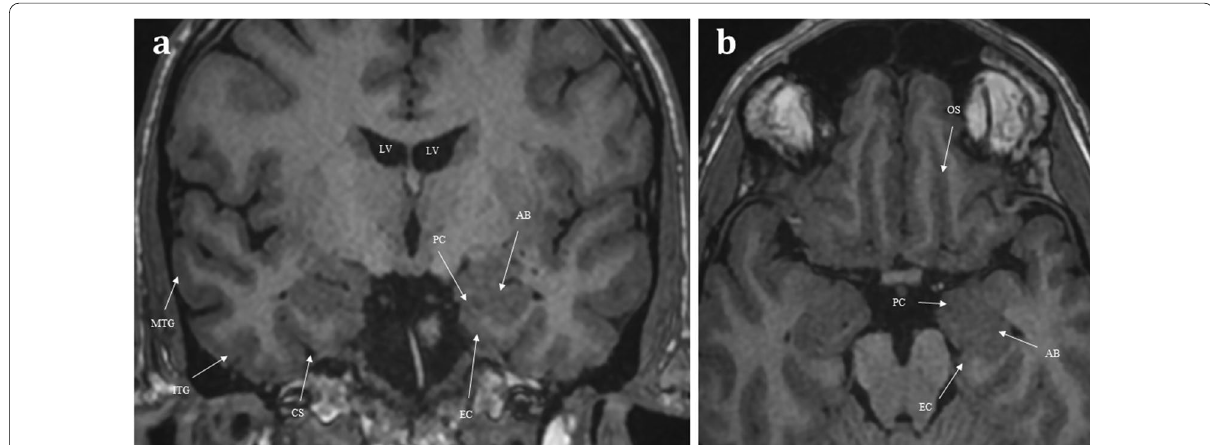
Fig. 3 Coronal T1 weighted image taken at the level of the lateral ventricles (LV) and foramina of Monroe ( a ), and axial T1 weighted image of the inferior frontal lobe and mesial temporal lobes ( b ). The olfactory tracts (not pictured) run within the olfactory sulci (OS) and transmit second-order neurones to the central olfactory regions. These are housed within the mesial temporal lobe and include the parahippocampus, the entorhinal cortex (EC), the piriform cortex (PC), and the amygdaloid body (AB). Note the other sulcal landmarks including the collateral sulcus (CS) which bounds the entorhinal cortex inferiorly, as well as the inferior temporal gyrus (ITG), and the middle temporal gyrus